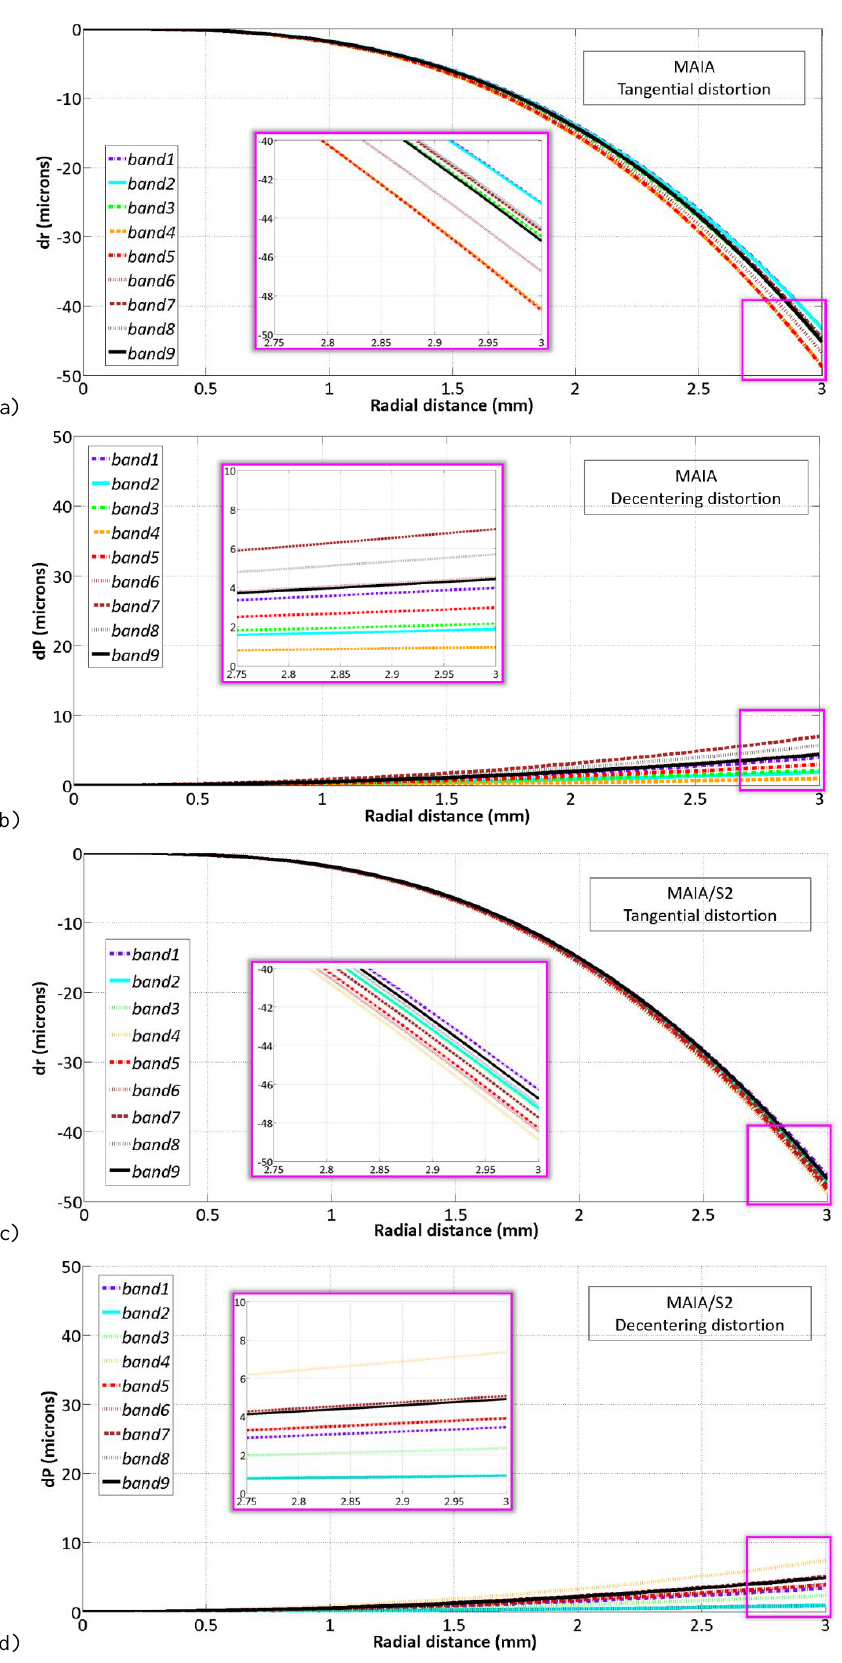
Figure 4. Typical radial (a, c) and decentring (b, d) distortion curves of the nine MAIA (a, b) and MAIA/S2 (c,d) spectral